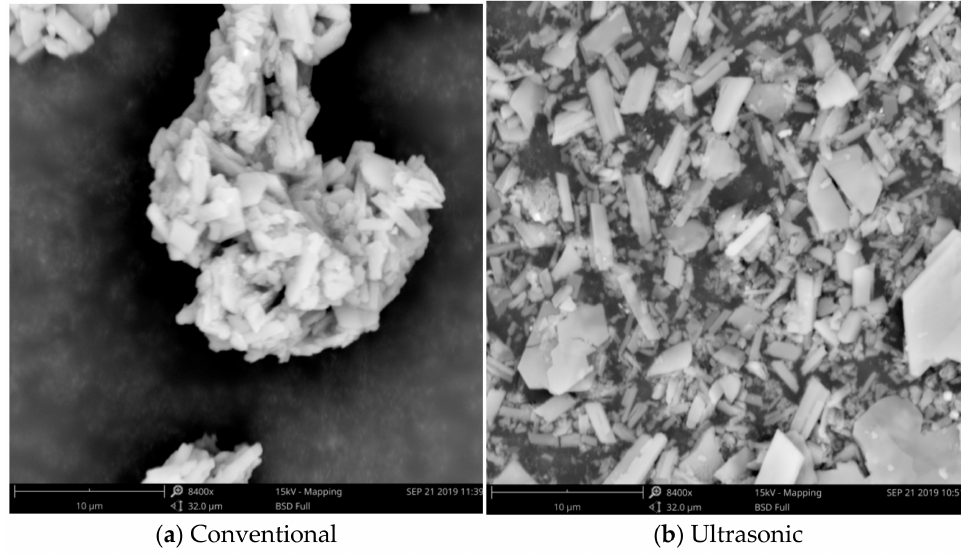
Figure 14. SEM of residue after leaching. ( a ) Conventional: mass fraction of sulfuric acid = 15%, particle size = − 150 µ m, solid–liquid ratio = 1:7, temperature = 25 ◦ C, stirring speed = 150 rpm, leaching time = 80 min; ( b ) ultrasonic: power = 600 W, mass fraction of sulfuric acid = 15%, particle size = − 150 µ m, solid–liquid ratio = 1:7, temperature = 25 ◦ C, leaching time = 40